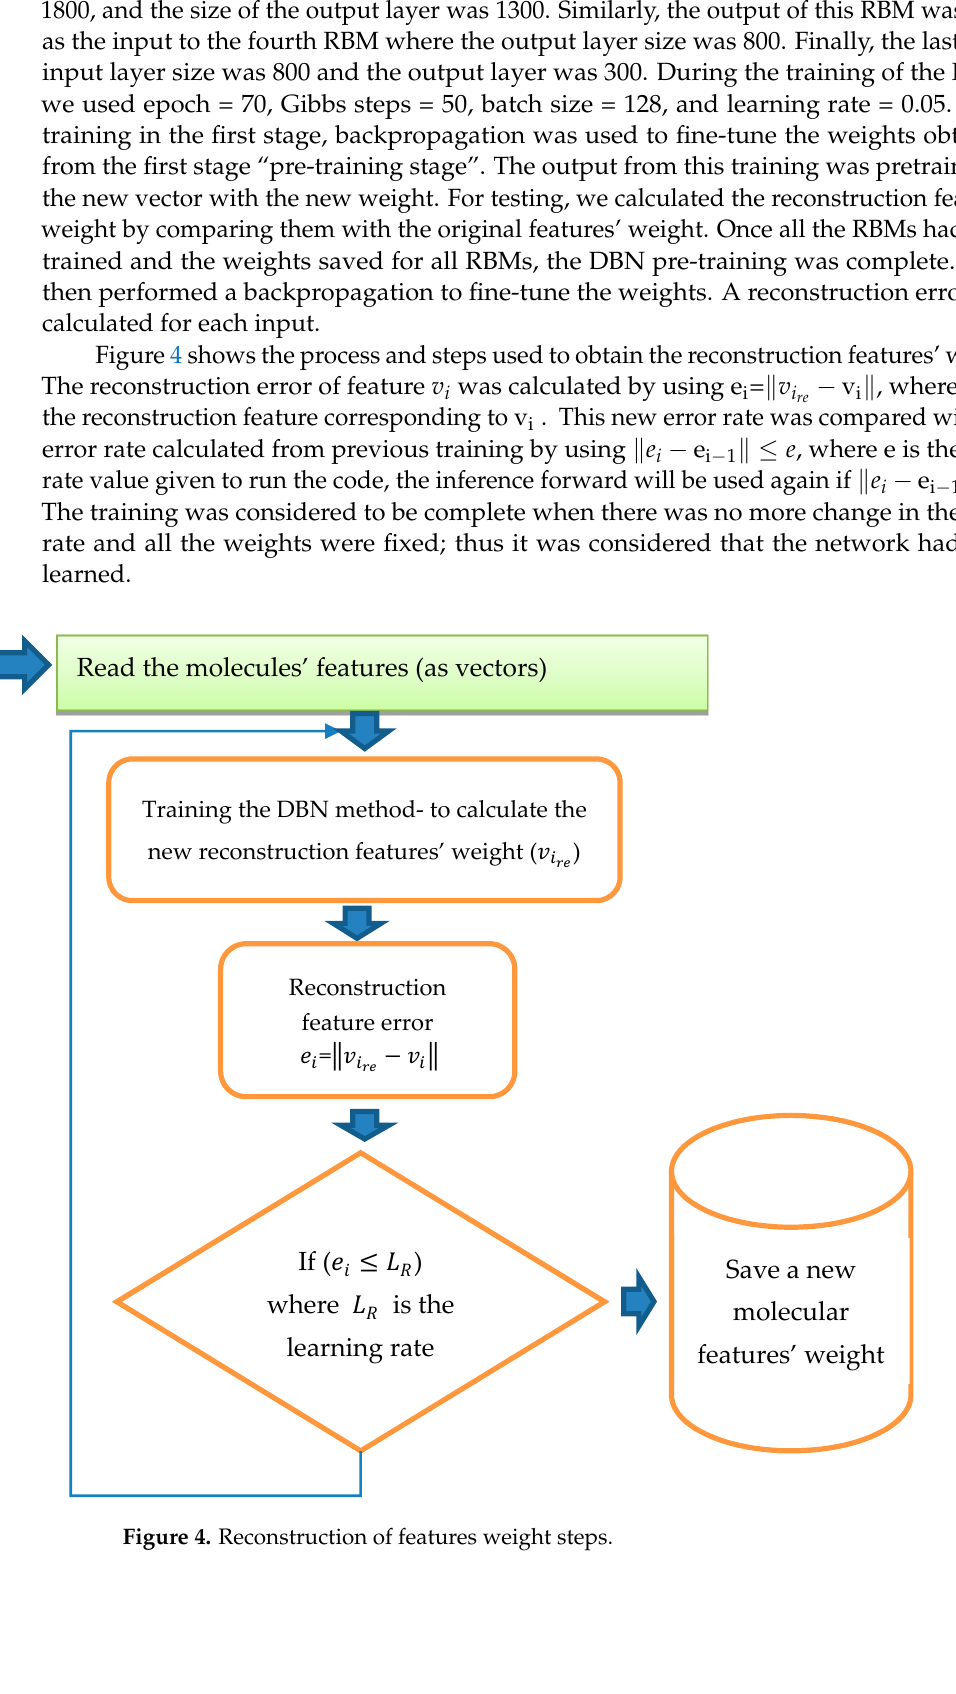
Figure 5. Dimensionality reduction and feature filtering processes.